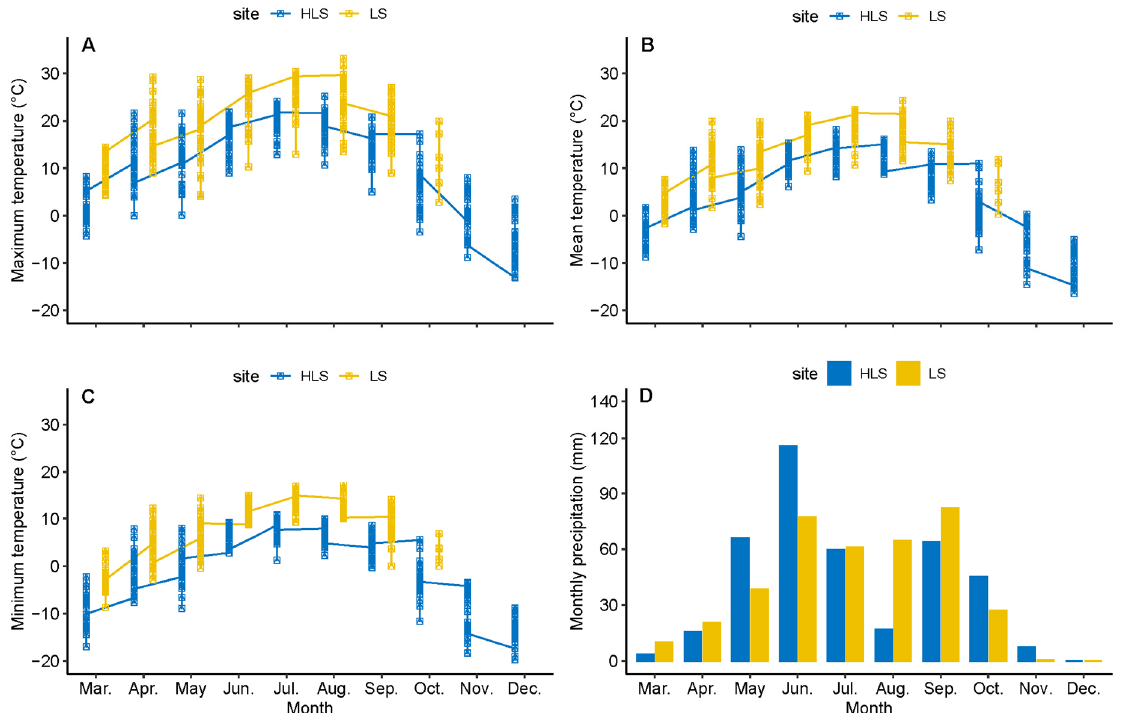
Figure 2. Monthly 2019 climate data monitored by the weather stations nearest to the sampling sites in Helanshan and Luoshan in northwest China. Values in ( A – C ) are presented as the daily maximum temperature ( A ), mean daily temperature ( B ), and daily minimum temperature ( C ) in the corresponding month; values in ( D ) are pre-sented as the monthly accumulated precipitation.